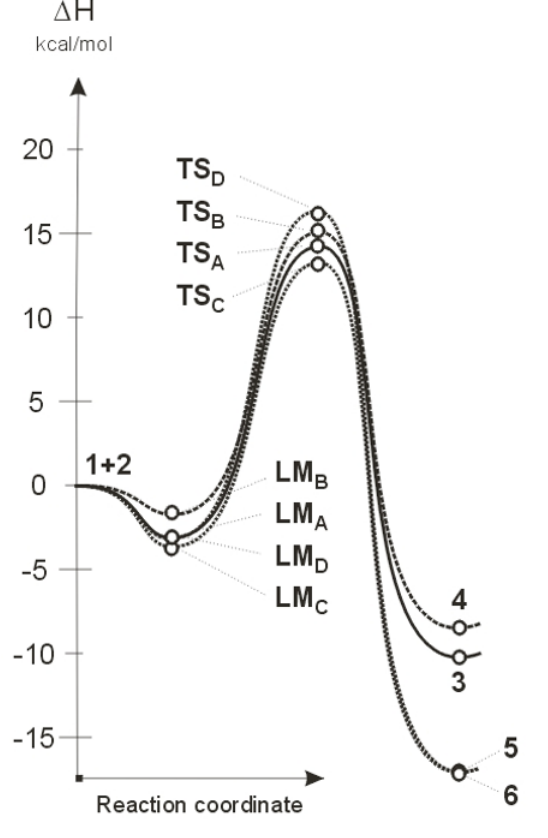
Figure 1. Enthalpy profiles for the [2+3] cycloaddition of a -phenylnitroethene 1 and (Z)-C,N-diphenylnitrone 2 in gas phase according to B3LYP/6-31G(d) calculations (298